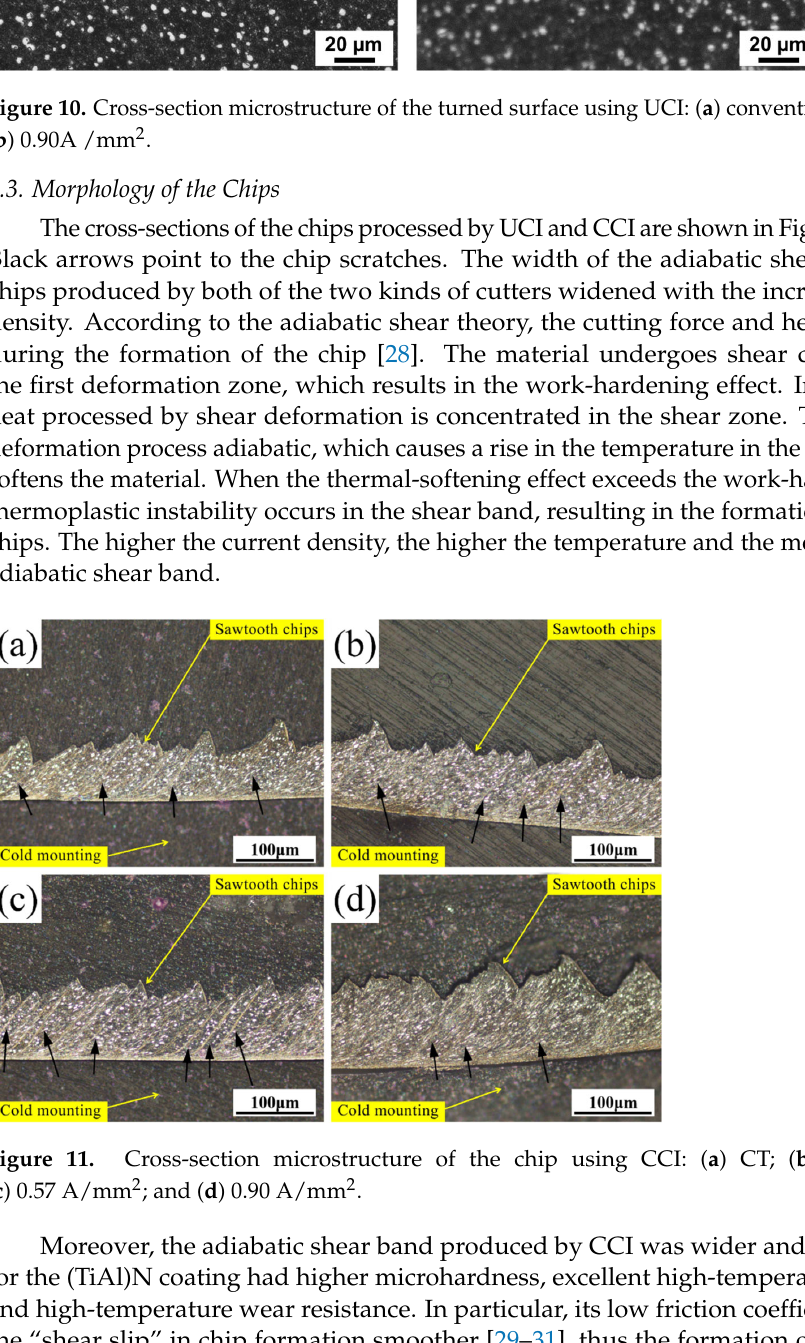
Figure 10. Cross-section microstructure of the turned surface using UCI: ( a ) conventional cutting and ( b ) 0.90A /mm 2 .